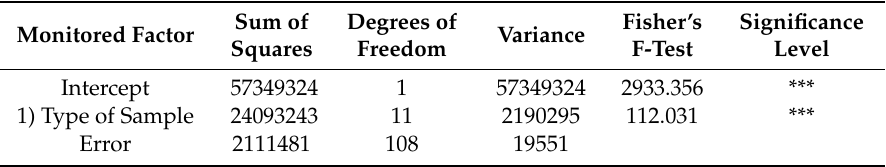
Table 15. Statistical evaluation of the e ff ect of the factors and their interaction on the minimum bend radius at the yield point ( R minB ) for aspen and NWC on the